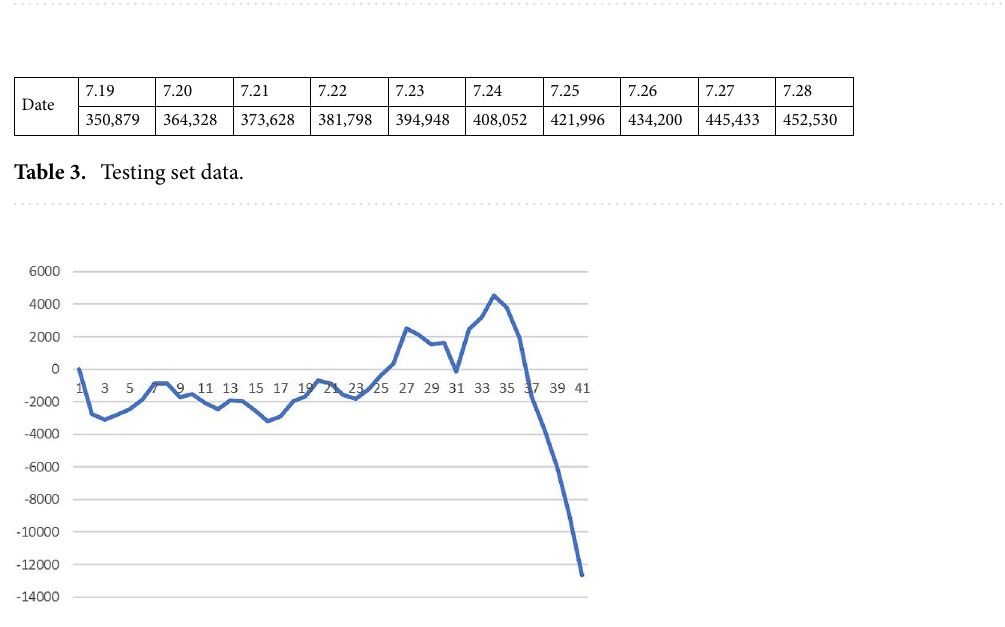
Figure 3. Residual of GM (1,1) simulation